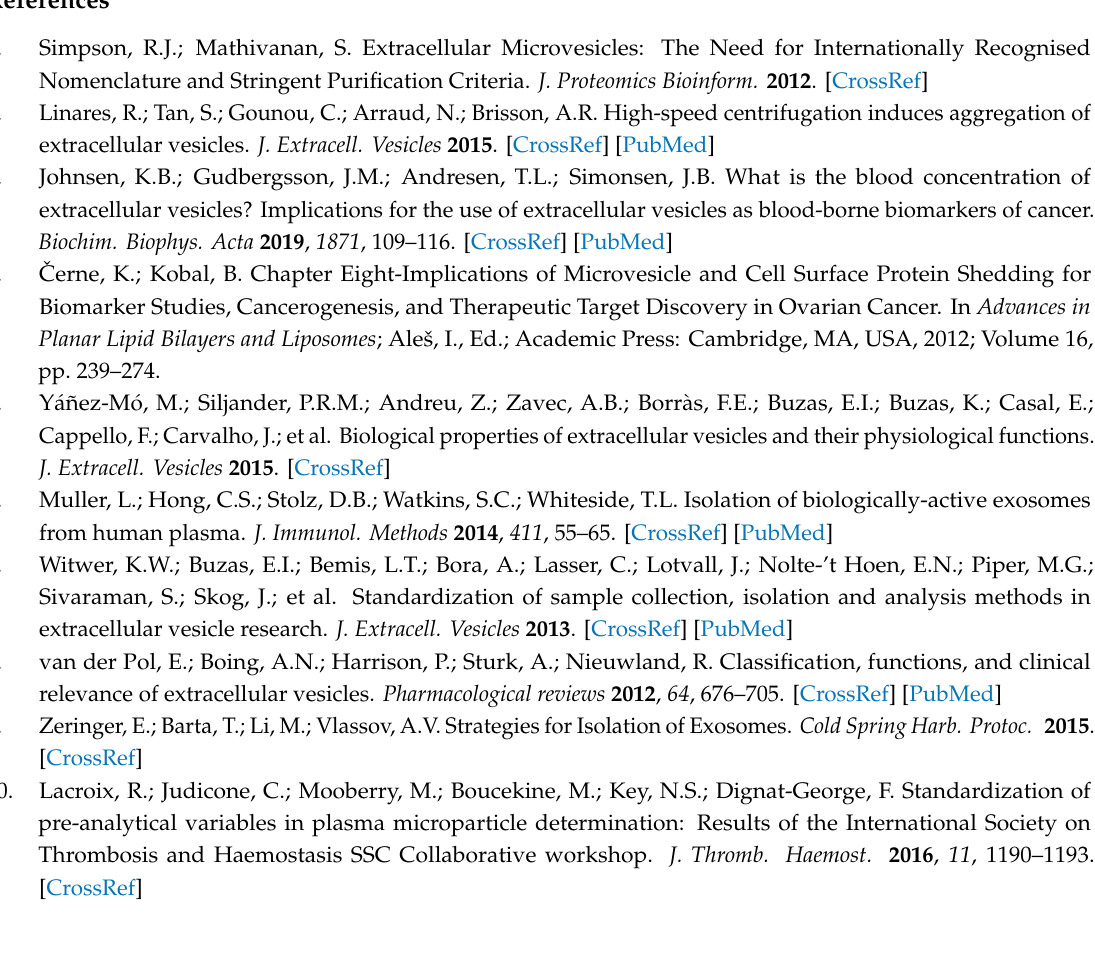
Scheme S1: Vesicle structure parameters for the form factor derivation, Figure S1: Dynamic light scattering data transformation–from the measured correlation function to the size distribution, Figure S2: Kratky plot representation of the static light scattering data–some theoretical functions, Figure S3: Gating strategy for the analysis of EVs by FCM, Figure S4: Measured correlation function (G2(t)), calculated g1(t) and intensity distributions for an exosome standard, blood plasma and EV isolate from it, Figure S5: Comparison of the angular dependency of the hydrodynamic radii, Rh, and the reciprocal scattered light intensity for the population 2 in the unfiltered and filtered exosome standard, Figure S6: Photography of blood plasma after 8-h of ultracentrifugation at 100 000 × g, Figure S7: SDS-PAGE of blood plasma and its fractions obtained after 8-h of ultracentrifugation at 100 000 × g, Table S1: Results of the DLS and SLS analysis of EVs in the exosome standard, Tables S2–S4: Results of the DLS and SLS analysis of EVs in blood plasma of three healthy donors, Table S5: Density and dynamic viscosity of the fractions obtained in the preliminary blood plasma sedimentation test, Table S6: Results of DLS analysis for fractions obtained in the preliminary blood plasma sedimentation test, Table S7: Dynamic viscosity of blood plasma and its fractions after 8-h of ultracentrifugation at 100 000 × g, Table S8: Protein contents of plasma fractions obtained after 8-h ultracentrifugation at 100 000 ×